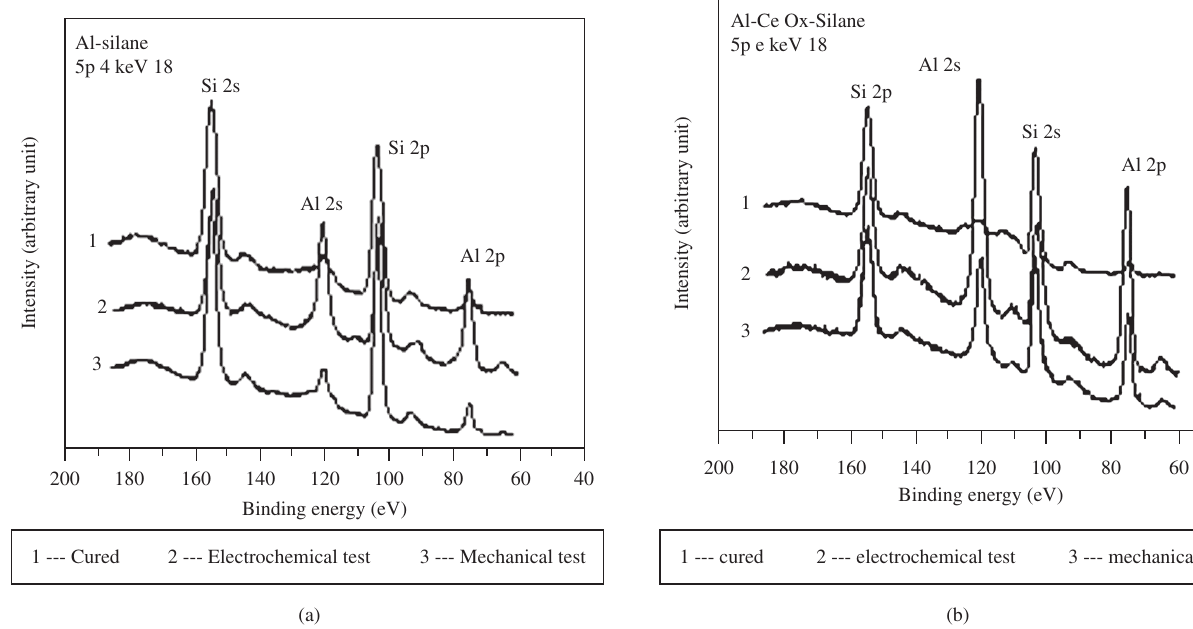
Figure 5. XPS analysis showing Al 2s and Si 2p signals from an AA 2024-T3 coated with Al-Si a), Al-Ce-Si b), before and after mechanical and electrochemi- cal test.